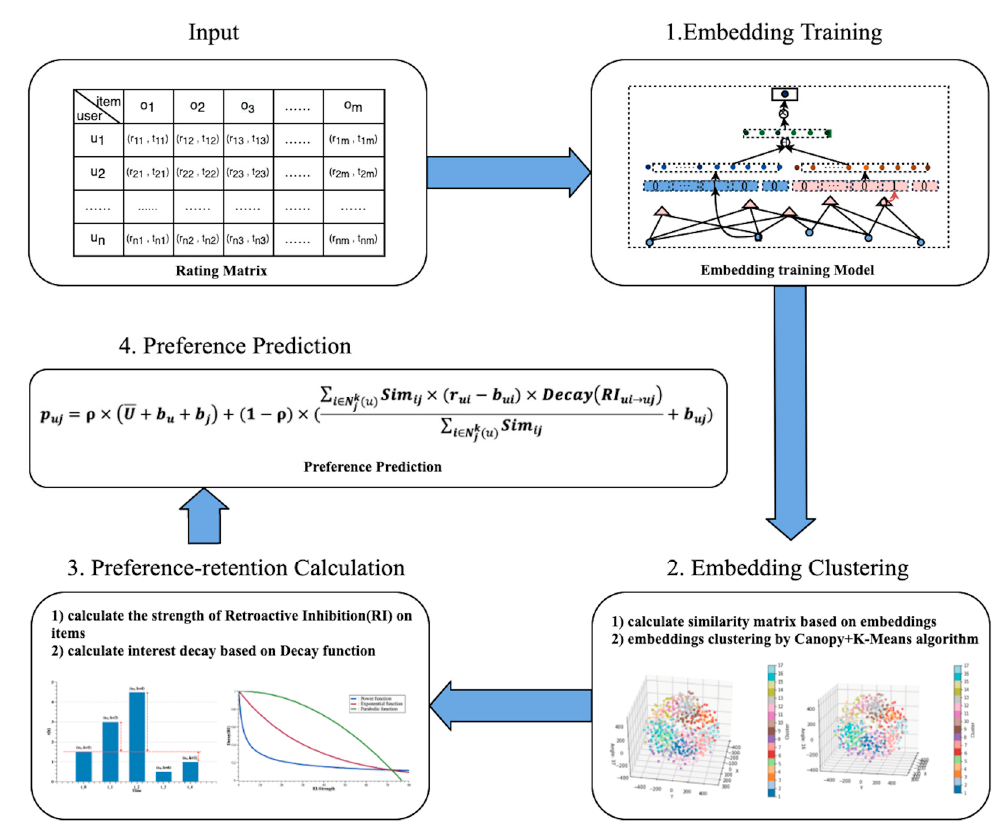
Figure 2. Workflow of proposed algorithm retroactive inhibition of preferences (RICF).